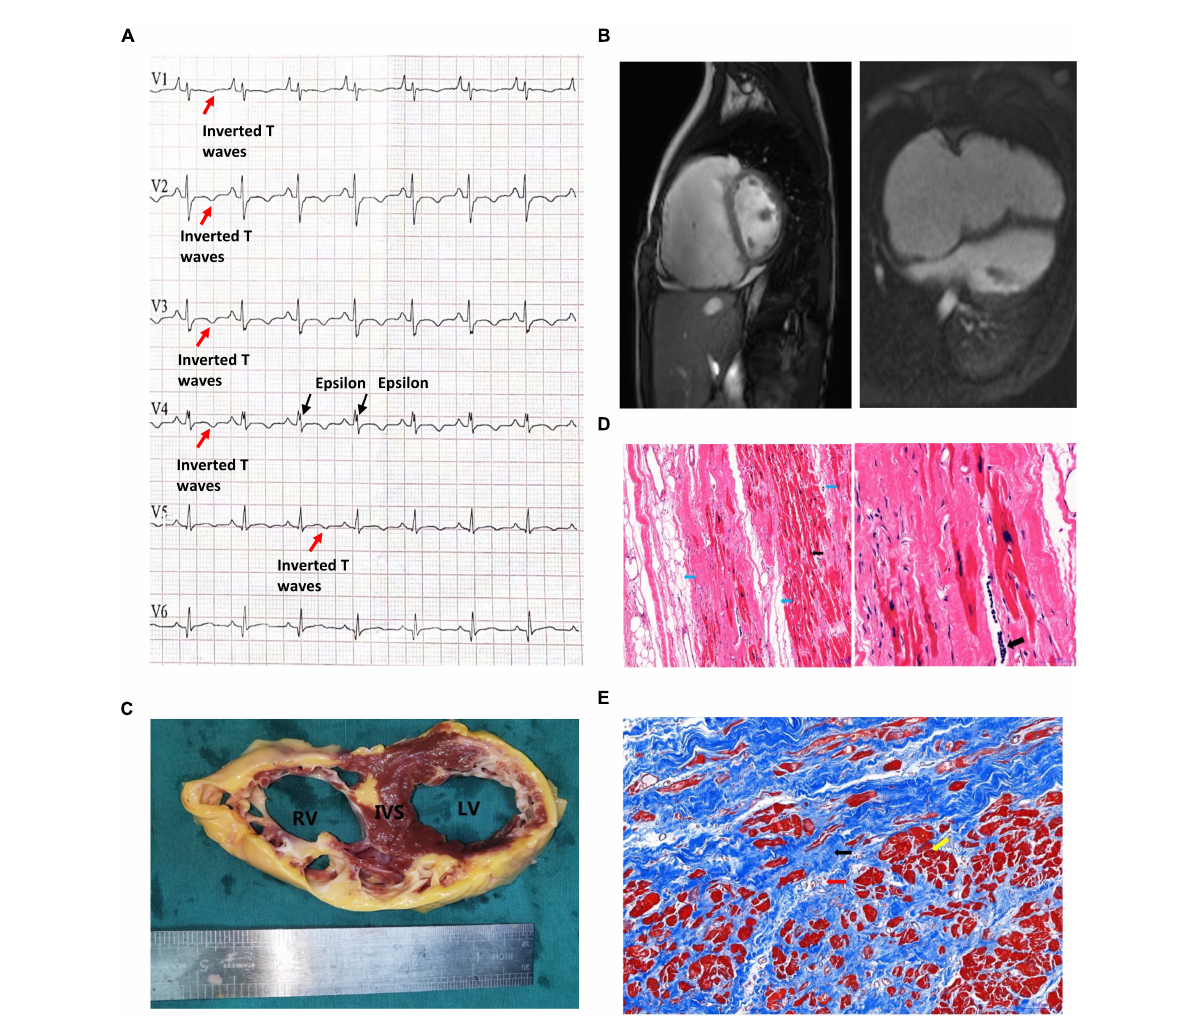
FIGURE1 Clinical presentation of the proband. (A) The patient’s preoperative ECG showed inverted T waves in lead V1, V2, V3, V4, and V5, with typical Epsilon waves visible in V4. (B) Preoperative cardiac MRI of the patient indicated that the right atrium was significantly enlarged, the right ventricular wall was thinner, the right ventricular wall edge was localized in many places, and the amplitude of myocardial contraction of the right ventricle was significantly reduced. (C) The myocardium was replaced by extensive fibrous adipose tissue in the wall of the right ventricle (RV), the right ventricle was bag like and thinly dilated, part of the ventricular septum (IVS) was adipose, and part of the myocardium in the anterior and lateral wall of the left ventricle (LV) was replaced by adipose fibers. (D) HE staining of the myocardium of the right ventricle: Left: the blue arrow indicates the adipose tissue, and the myocardium of the right ventricle is surrounded by the adipose tissue and divided into cords. The black arrow shows abnormal hypertrophic cardiomyocytes with large, dark-stained nuclei and oddly shaped nuclei, broken muscle fibers in the cytoplasm of the cardiomyocytes (magnified 100 × ). Right: The black arrow indicates the presence of inflammatory cell infiltration between cardiomyocytes at magnified 200 × . (E) Masson staining of the myocardium of the right ventricle. Note that the myocardium (the yellow arrow) is surrounded by large amount of fibrous adipocytes (the black arrow) and divided into cords or islands. The collagenous fiber bundles around small blood vessels (red arrows) are increased.